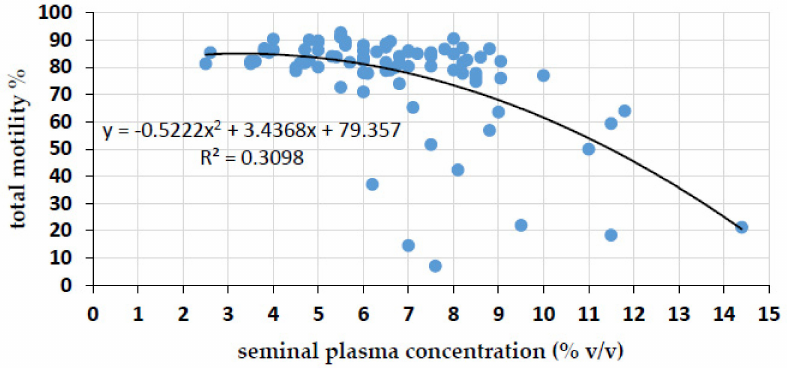
Figure 1. Sperm motility in relation to the concentration of seminal plasma in the semen dose. Pearson’s correlation ( r = − 0.52, p < 0.0001) between sperm motility at 144 h of storage and the concentration of seminal plasma in uncentrifuged semen portions extended to 18 × 10 6 sperm / mL in 100 mL volume; n = 87 semen samples from 19 di ff erent boars.